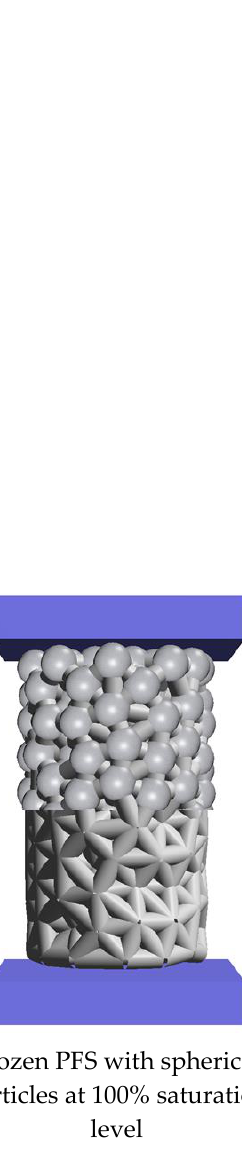
Table 5. Agglomerates bond generation set up for different types of PFS in 75% saturation level.